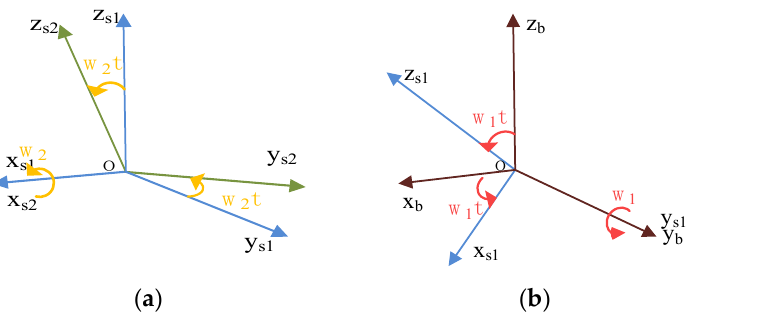
Figure 5. Compound rotation modulation system coordinate transformation diagram: ( a ) b-frame and s1-frame transformation diagram; ( b ) s1-frame and s2-frame transformation diagram.